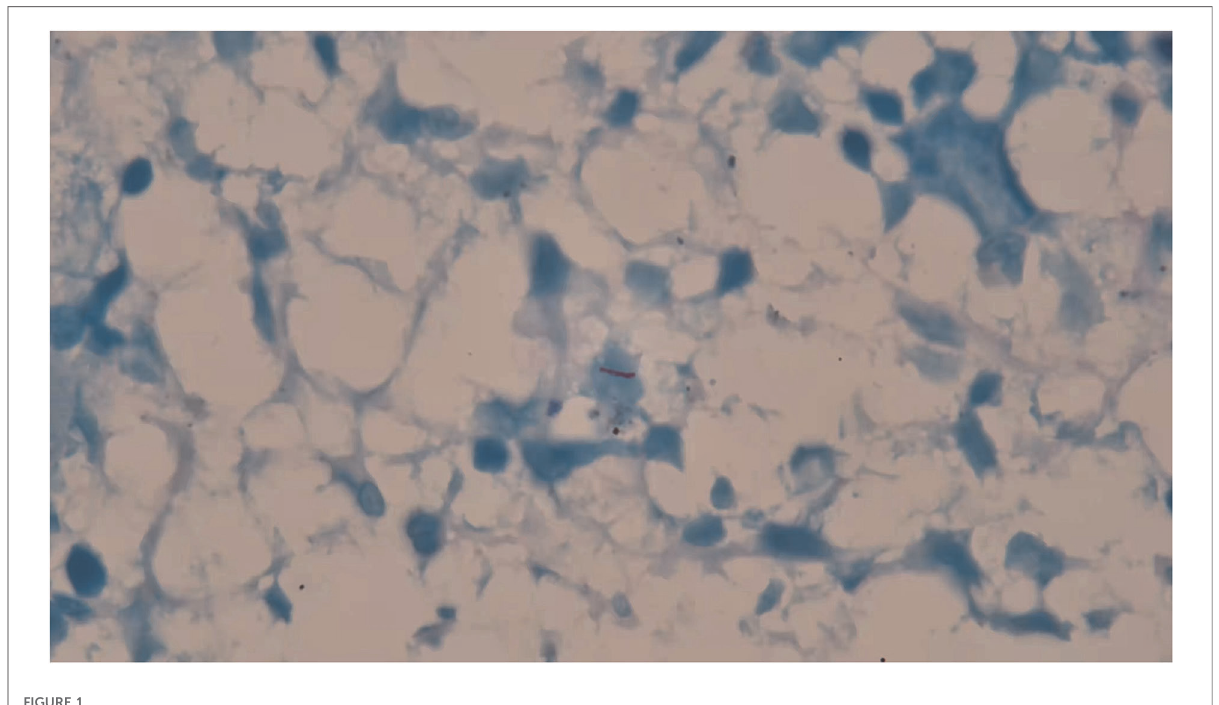
FIGURE 1 Mycobacteria tuberculosis identi fi ed in bone marrow aspirate